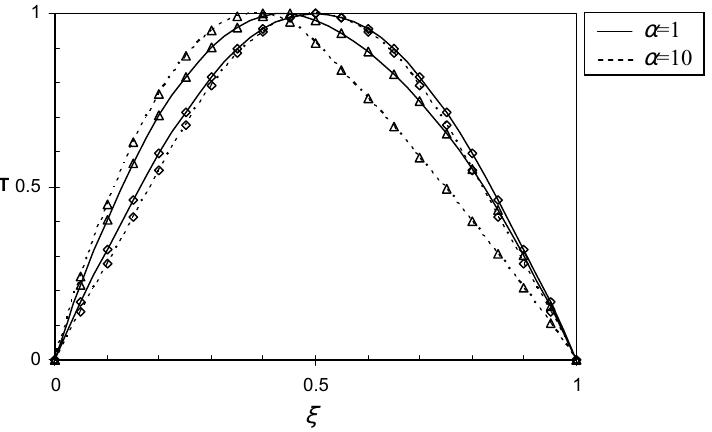
Fig. 4. The mode moments of a simply supported beam with a uniformly distributed spring-mass in respect to different positions and mass density ratios, ( ξ 1 = 0 . 0 , ξ 2 = 0 . 5 ), ( ξ 1 = 0 . 25 , ξ 2 = 0 . 75